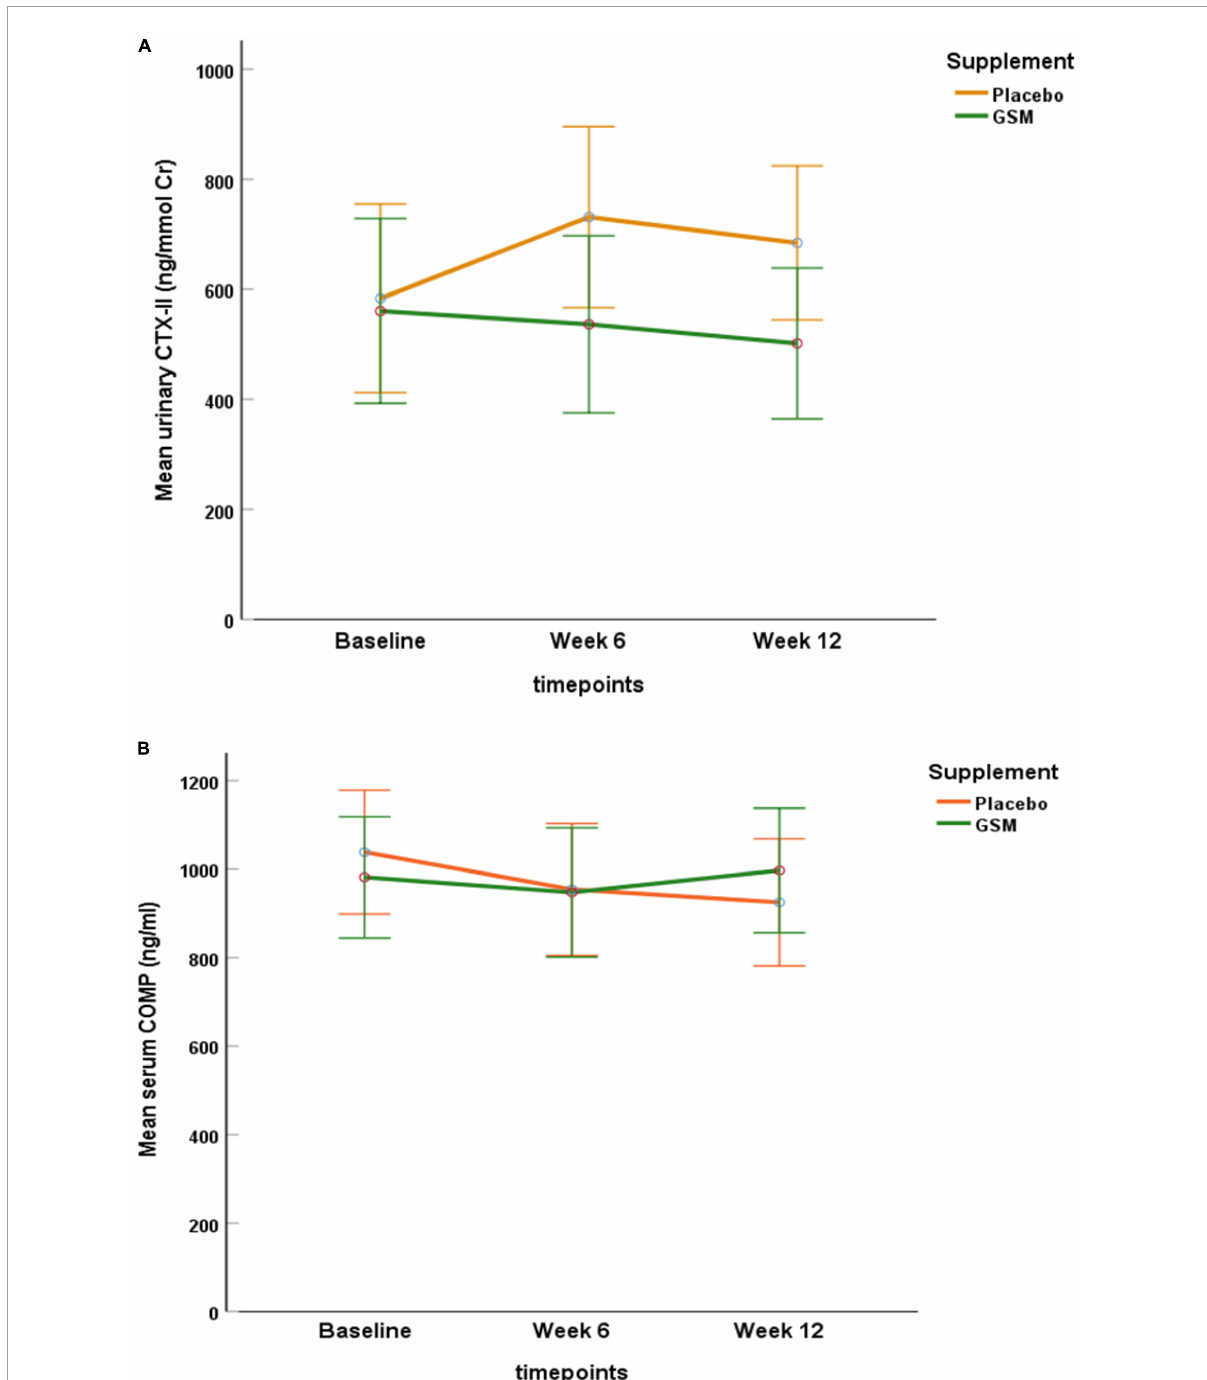
FIGURE2 Pattern of change in urinary C-telopeptide of type II collagen (CTX-II) level (A) , and serum level of cartilage oligomeric matrix protein (COMP) (B) over the study period (baseline, follow-up, and endpoint) within each of the treatment groups. No significant neither over time nor between the groups for urine CTX-II and serum COMP (interaction effect P = 0.3, P = 0.1, respectively). Data are expressed as the mean ± standard error.